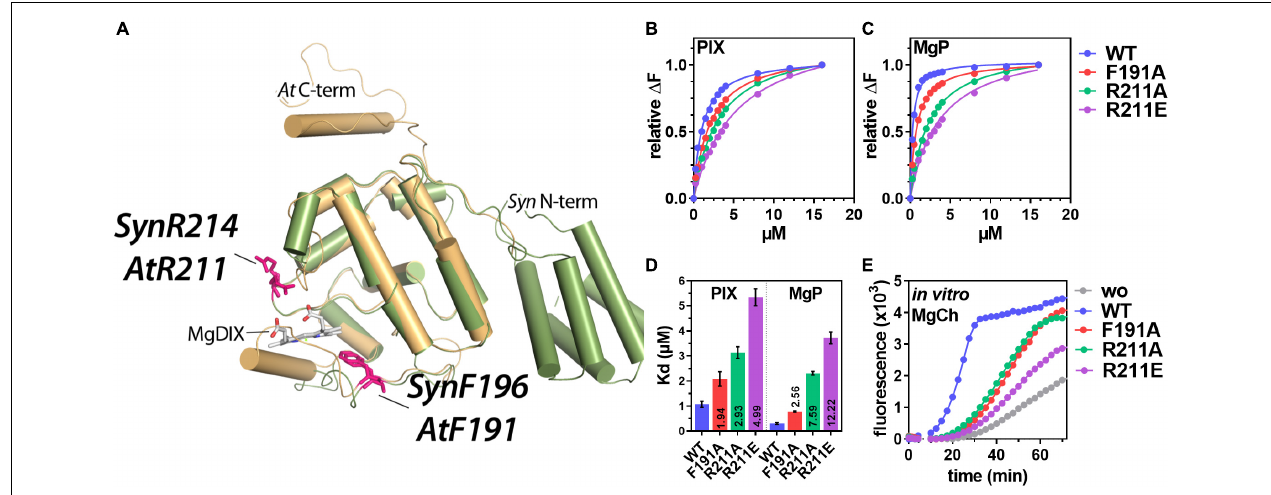
FIGURE 1 | In vivo analysis of porphyrin binding and Mg-chelatase (MgCh) activity in the presence of WT and mutant GENOMES UNCOUPLED 4 (GUN4). (A) Overlay of the three-dimensional structure of Synechocystis ( Syn ) GUN4 (green) and a predicted structure (PHYRE 2 , Kelley et al., 2015) of Arabidopsis thaliana ( At ) GUN4 (beige). The crystal of Synechocystis sp. PCC 6803 GUN4 (1Y6I) contained the porphyrin derivate - magnesium deuteroporphyrin IX (MgDIX) - which resembles the native product of the MgCh reaction (MgP). Amino acids analyzed in this study are highlighted (pink). (B,C) Analysis of PIX (B) and MgP (C) binding to GUN4(WT) and substitution mutants of GUN4 using Trp-fluorescence quenching analysis. Data points for the relative fluorescence quenching ( α F) reflect the mean of a total of five titration curves from two independent protein purifications. The maximum fluorescence quenching efficiency of the highest porphyrin concentration was set to 1. (D) Apparent dissociation constants (Kd) for PIX and MgP binding to GUN4, calculated from the binding curves shown in panels (B,C) (mean ± S.E.) for n = 4 binding curves analyzed with independent protein preparations). Values inside the bars indicate the fold change of the Kd relative to the WT protein. (E) In vitro MgCh assay using recombinant rice ( Oryza sativa ) MgCh subunits in the absence (gray) or presence of GUN4 (WT) (blue), GUN4(F191A) (red), GUN4(R211A) (green) and GUN4 (R211E) (purple), respectively. The formation of the MgCh reaction (PIX) product was monitored as an increase in fluorescence emission at 595 nm. MgCh assays were repeated three times with proteins from independent purifications, and one representative result is